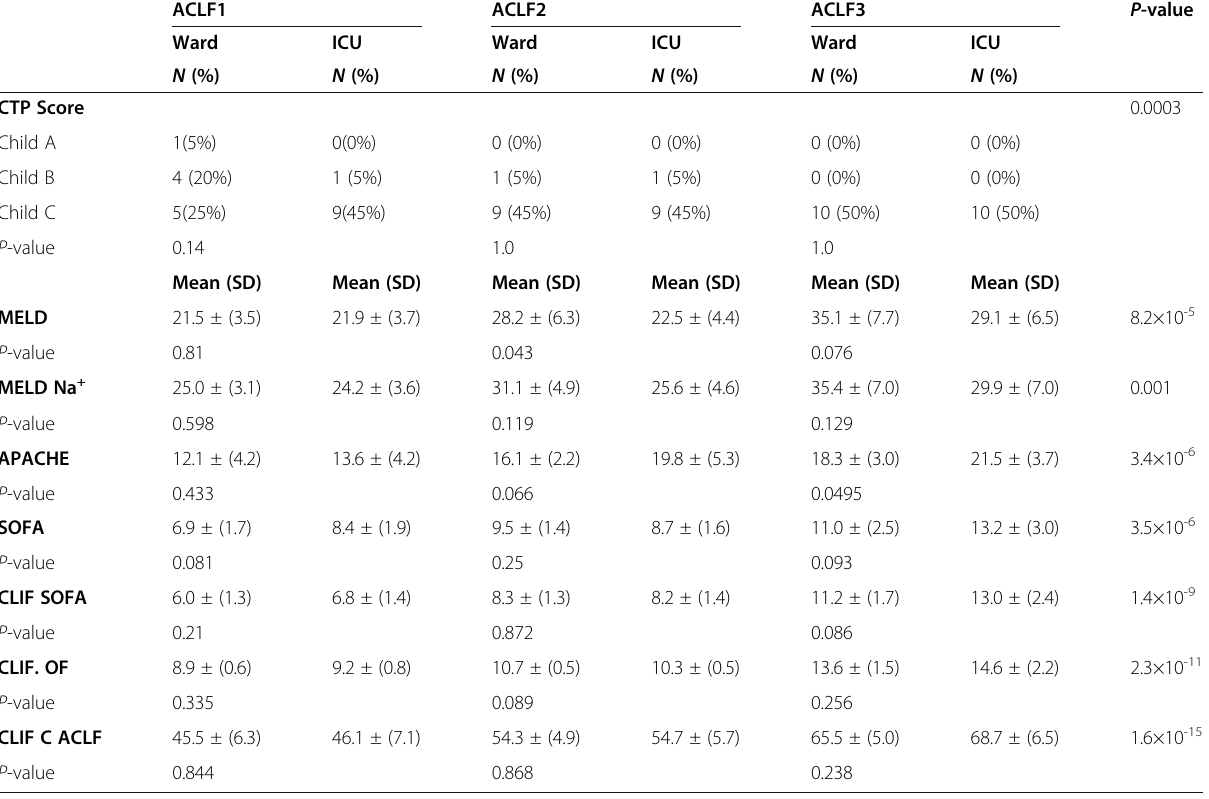
Table 5 Prognostic scores for the 3 ACLF degrees in both ward and ICU